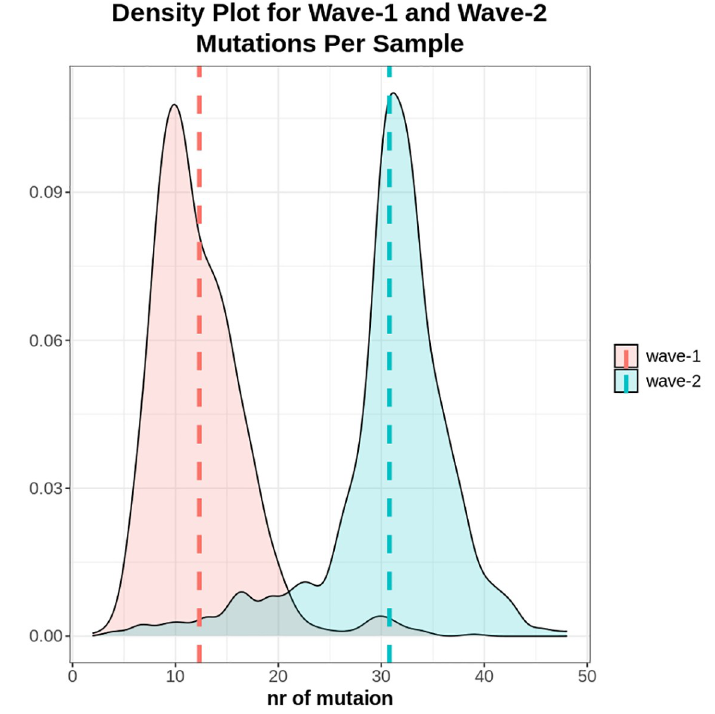
Fig 1. Density plot of mutations per sample in case of wave-1 and wave-2. The Red line and Blue line represent the average value of mutation per sample for wave-1 and wave-2 respectively. Wave-2 samples generally possessed a higher number of mutations per sample than